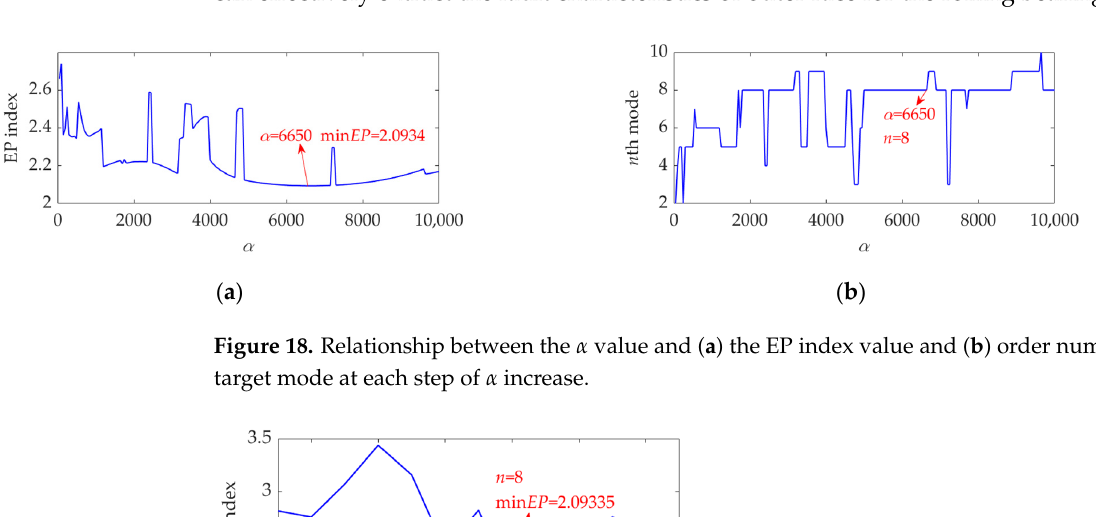
Figure 19. The EP index value of each mode.